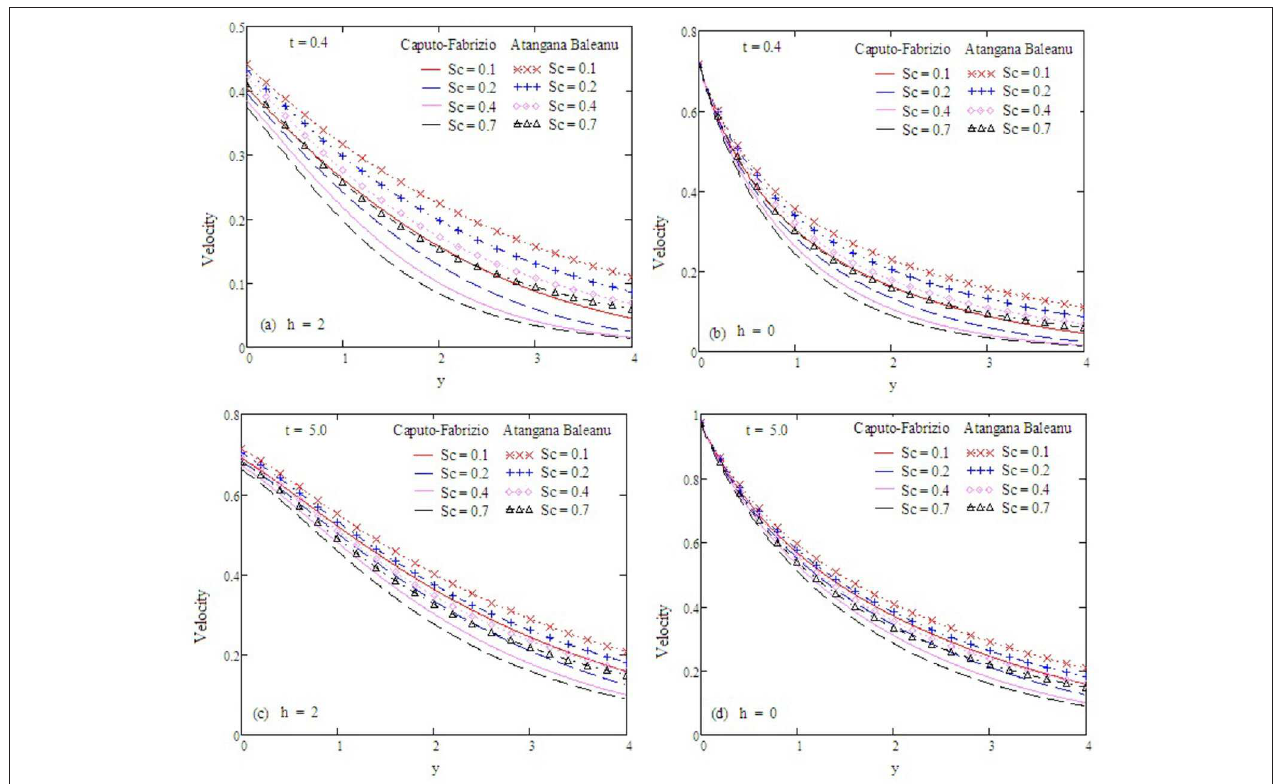
FIGURE 16 | Velocity profiles with altered values of S c and other parameters are ω